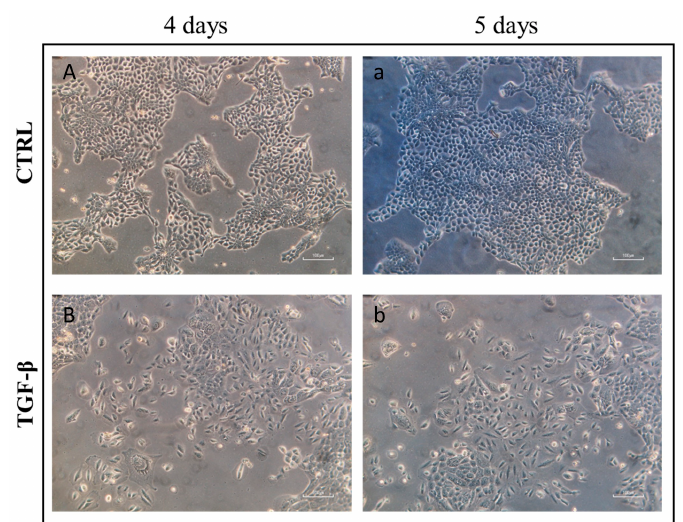
Figure 1. TGF- β 1 triggers morphological changes in MCF-10A cells after five days of induction. Images on light microscopy of MCF-10A cells. In physiological conditions, epithelial cells are polarized, display a cuboidal-like morphology, and interact with each other through cell–cell junction ( A , a ). Upon TGF- β 1 addition, cells lose cell–cell junction, and apico–basal polarity assumed a fibroblast-like morphology and became scattered over the entire area ( B , b ), thereby losing reciprocal connectivity and the tissue-like architecture.